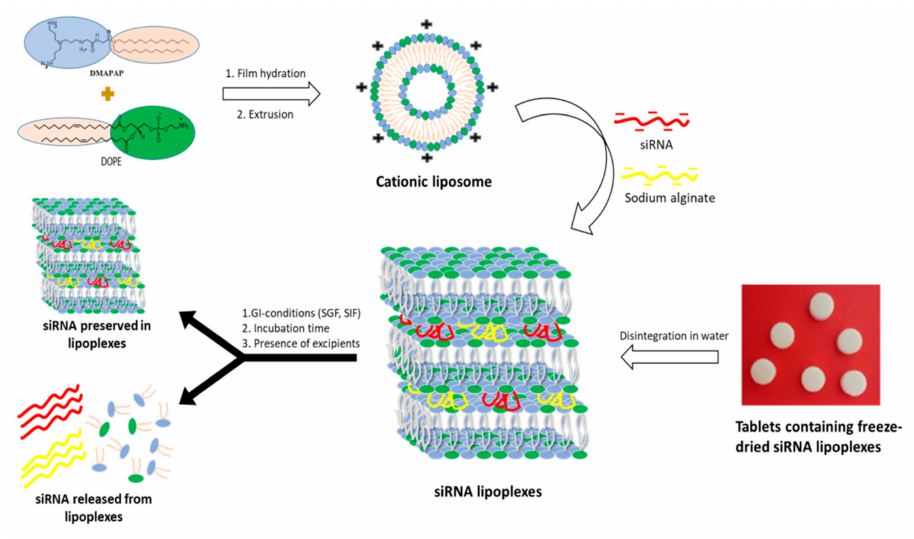
Figure 1. Preparation of siRNA lipoplexes and evaluation of the stability of siRNA and siRNA lipoplexes in gastrointestinal (GI)